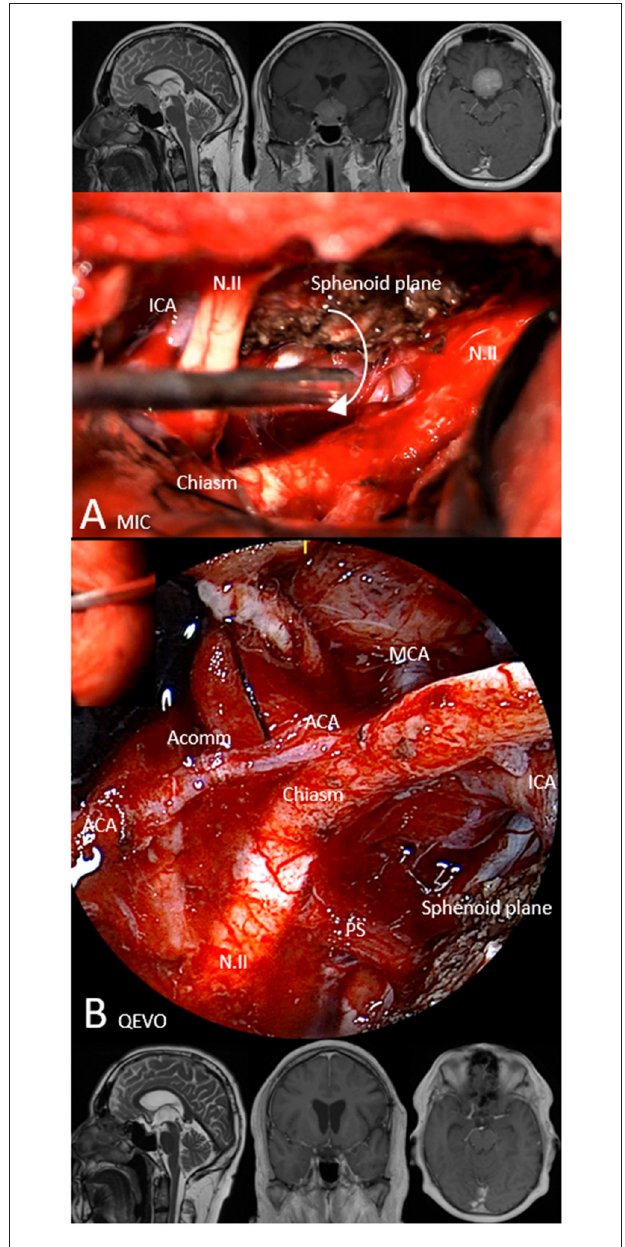
FIGURE 2 | Illustrative case 1—area 1, QEVO ® category D. Patient #15, meningioma WHO I of the sphenoid plane, left pterional approach. Upper row, Preoperative MRI in sagittal plane (T2), coronal plane, and axial plane (T1 with contrast medium); (A) MIC(roscopic), Microscopic image at the end of tumor resection. The white arrow indicates the position and visual trajectory for the micro-inspection tool QEVO® (B) ; (B) QEVO, Endoscopic image enabling the view below the tumor-free optic chiasm and the pituitary stalk, depicting the arteries of the anterior circulation. Lower row, Postoperative MRI in sagittal plane (T2), coronal plane, and axial plane (T1 with contrast medium). The white arrow indicates the visual trajectory for micro-inspection tool QEVO ® , ICA means Internal Carotid Artery, N.II, Optic nerve, MCA means Middle Cerebral Artery, ACA means Anterior Cerebral Artery, Acomm means Anterior Communicating Artery, PS means Pituitary